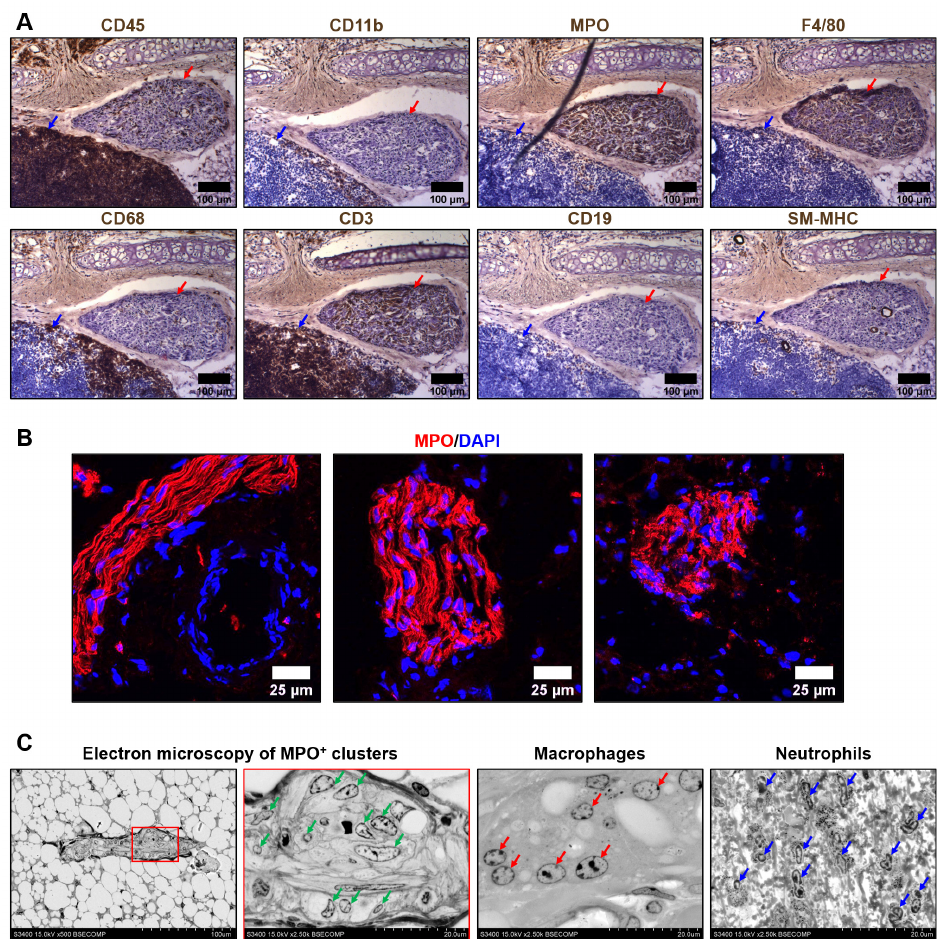
Figure 1. Immuno- and electron microscopy phenotyping of MPO + clusters reveals positive staining for myeloperoxidase and macrophage appearance of the cells. ( A ) Immunohistochemical staining for a pan-leukocyte marker CD45, myeloid cell markers CD11b and myeloperoxidase (MPO), macrophage markers F4/80 and CD68, T cell marker CD3, B cell marker CD19, and vascular smooth muscle cell marker SM-MHC. Note the positive staining of MPO + clusters (indicated by red arrows) for MPO, F4/80, and CD3. In contrast, the adjacent lymph node (indicated by blue arrows) is totally positive for CD45 and CD3. × 200 magnification (scale bar: 100 µ m); ( B ) Verification immunofluorescence staining for MPO. Note the positive MPO + clusters and a negative adjacent blood vessel (left image). Nuclei are counterstained with 4 (cid:48) ,6-diamidino-2-phenylindole (DAPI). × 400 magnification (scale bar: 25 µ m); and ( C ) EM-BSEM visualisation of MPO + clusters. Note the similarity of the cells within the MPO + clusters (indicated by green arrows) to macrophages (indicated by red arrows) but not neutrophils (indicated by blue arrows). The right MPO + clusters image ( × 2500 magnification) is a close-up of the left image ( × 500 magnification). × 500– × 2500 magnification (scale bar: 100 and 20 µ m, accelerating voltage: 15